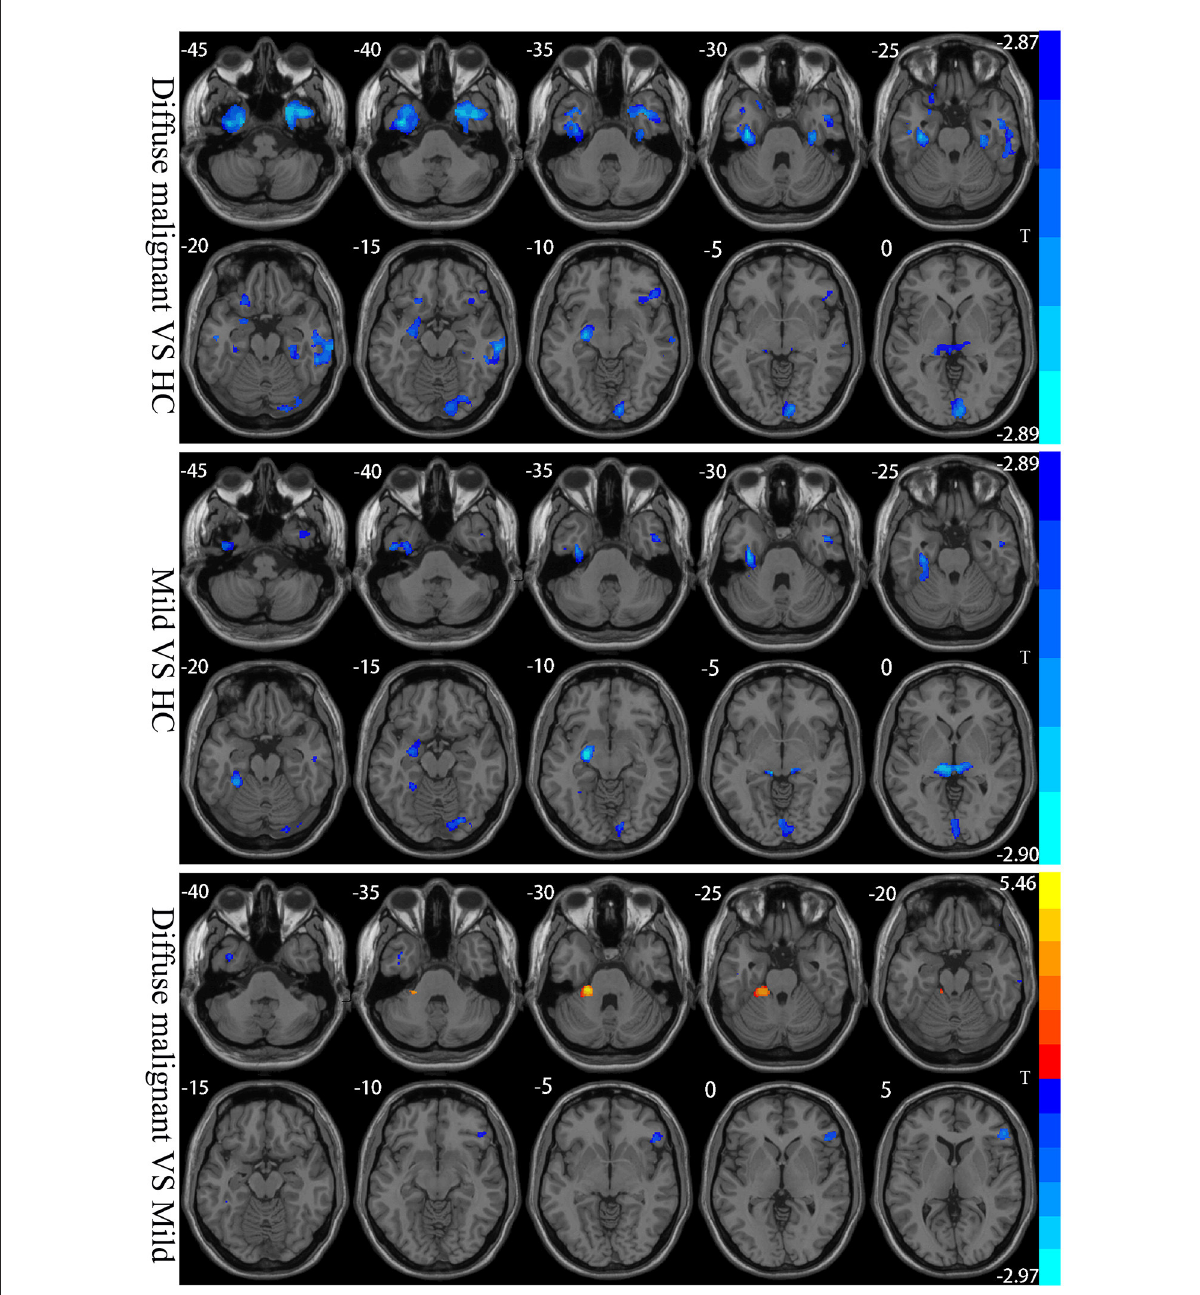
FIGURE3 Statistical parametric map showing the significant differences in the GMV between three groups: Diffuse malignant subtype, Mild and HC. GRF corrected (Voxel p < 0.005, cluster p < 0.05). The color bar on the right shows the statistical t-value. Warm (cold) overlays show higher (lower) GMV in PD